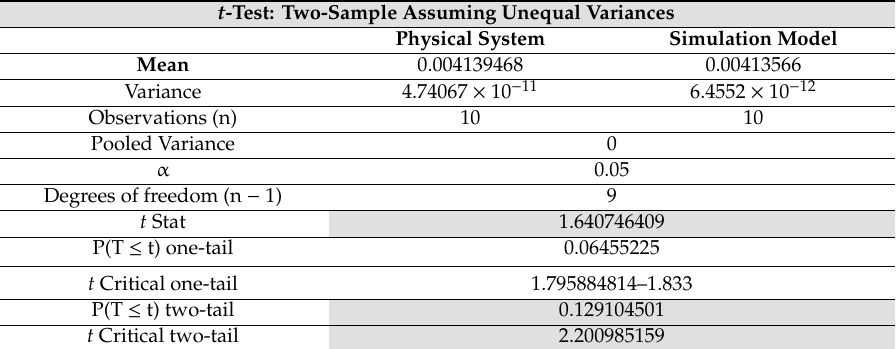
Table 1. Student’s t -test results to validate the Lego ® simulation model. t -Test: Two-Sample Assuming Unequal Variances